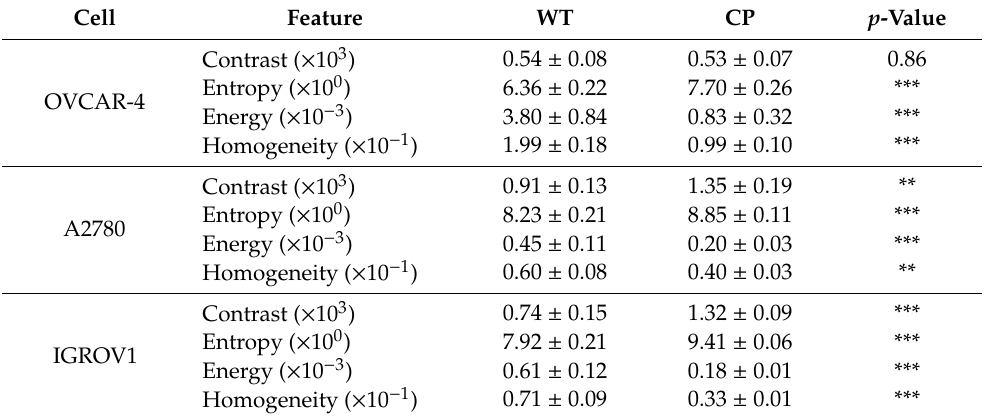
Table 1. Gray level co-occurrence matrix (GLCM) texture features for wild type (WT) and cisplatin-resistant (CP) of ovarian adenocarcinoma cells.